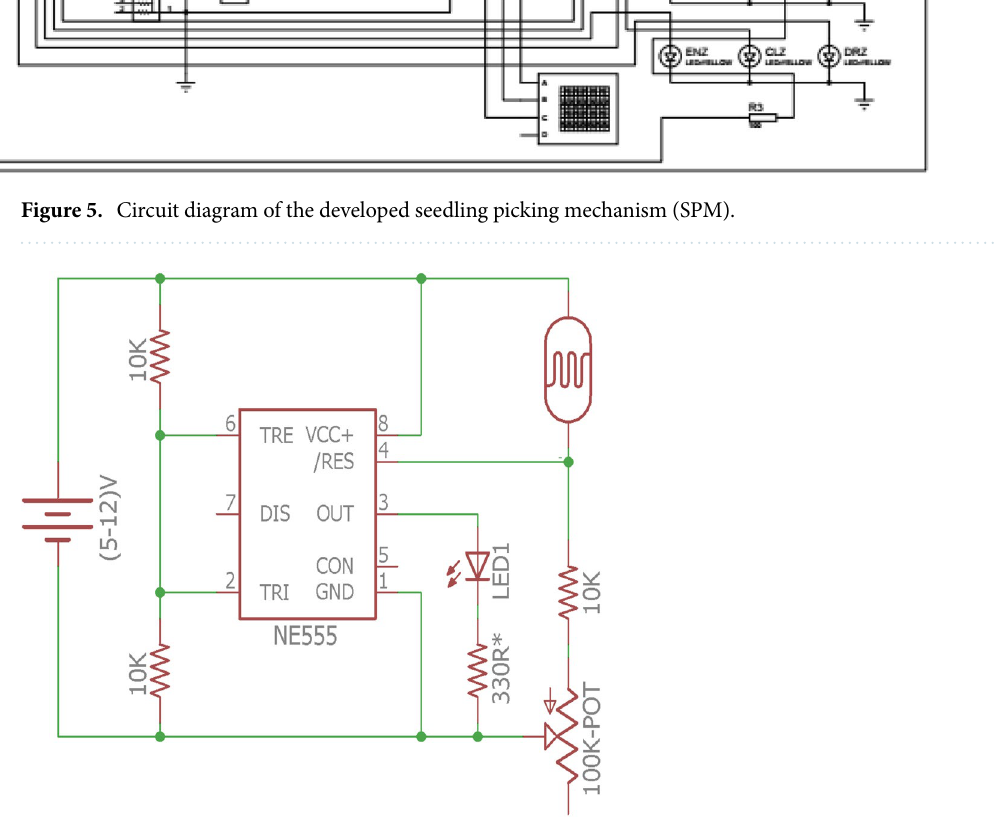
Figure 6. Circuit diagram of vehicle movement